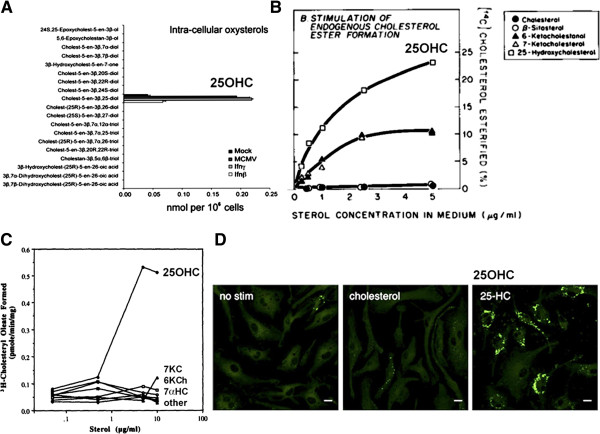
25OHC induction by immunostimulation or infection promotes cholesterol esterification and foam cell formation. (A) 25OHC is the only oxysterol induced by interferon (IFN) treatment or infection; panel from [309], with permission. (B) 25OHC stimulates cholesterol esterification in intact cells, from [316], with permission. (C) 25OHC is an allosteric effector of ACAT activity in insect cells expressing human ACAT, from [317] with permission; 7KC, 7-ketocholesterol; 6KCh, 6-ketocholestanol; 7αHC, 7α-hydroxycholesterol. (D) Treatment of bone marrow-derived macrophages with low-dose (ca. 0.1 μM) 25OHC, but not cholesterol itself, induces lipid body formation (BODIPY 493/503 fluorescence); scale bar 10 μm. From [318], with permission.